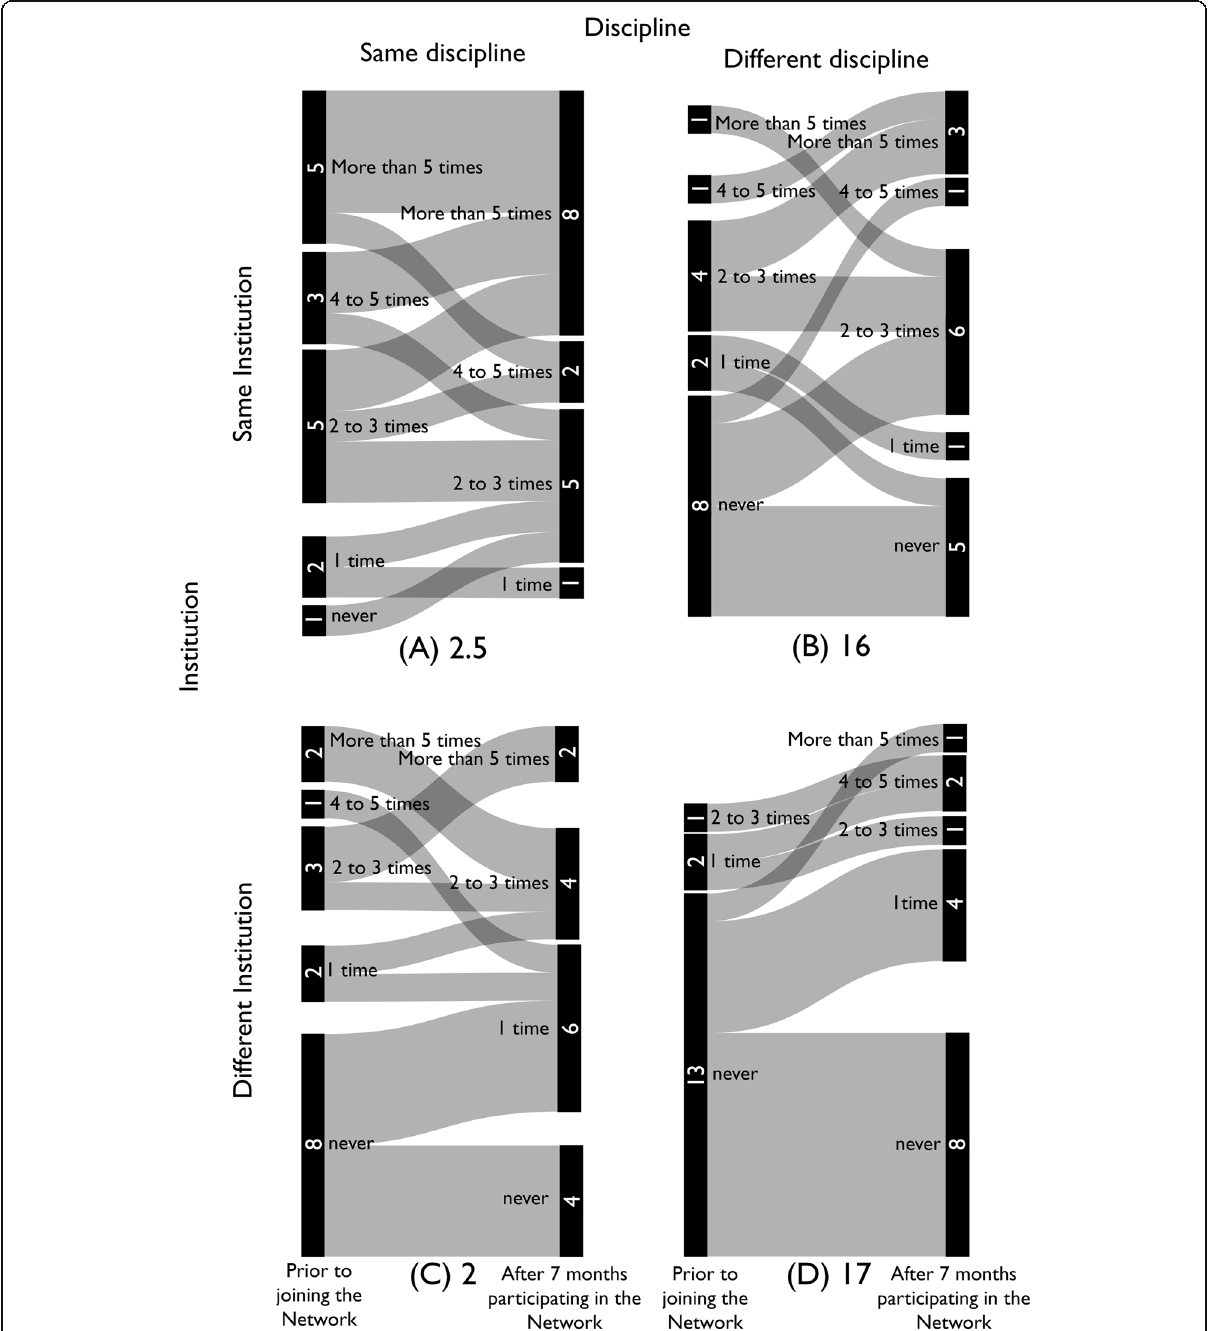
Fig. 6 Increase in Collaborations with Colleagues. The number of times participants reported collaborating with colleagues prior to joining the Network (left bars in each Sankey diagram) and after 7 months of participating in the (STEM) 2 Network (right bars in each Sankey diagram) in a the same discipline at their home institution, b different disciplines at their home institution, c the same discipline at other institutions, and d different disciplines at other institutions. The numbers below the figures represent the increase in participants ’ interactions from prior to joining the Network to 7 months after joining the Network. Interactions were calculated by multiplying the number of participants in each collaboration category at each time point by 0 (for never), 1 (for 1 time), 2.5 (for 2 – 3 times), 4.5 (for 4 – 5 times), and 6 (for more than 5